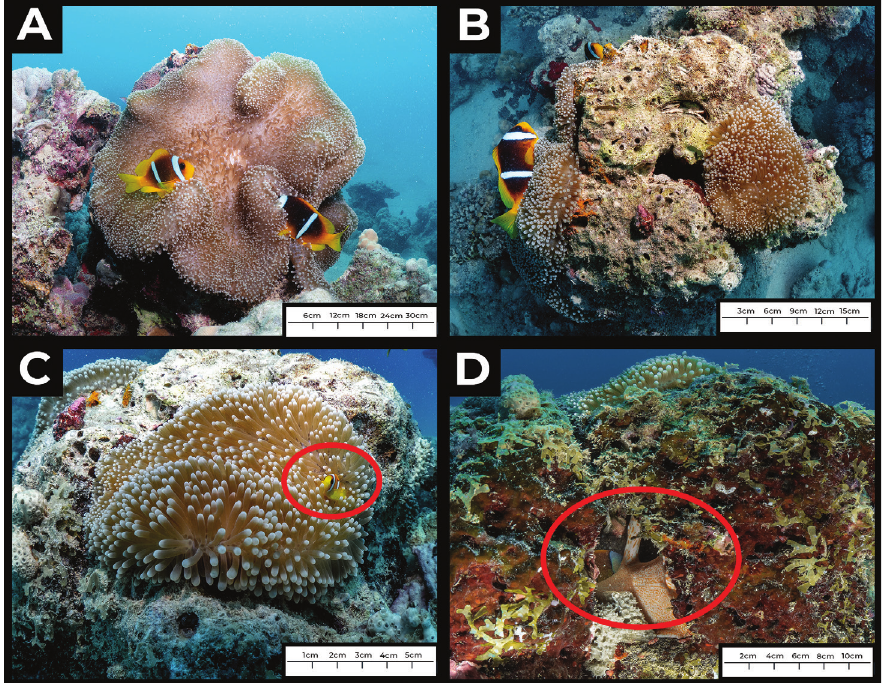
Figure 2. In situ images of asexual reproduction of Stichodactyla mertensii on an inshore reef near Thuwal, Saudi Arabia A the parent S. mertensii individual, with two Amphiprion bicinctus symbionts B top view of the parent individual (left, with anemonefish) and newly forming anemone bud (right) C anemonefish recruit (circled) in newly forming anemone bud D cross section of the reef rockwork, showing the column of the anemone from where the new fragmentation